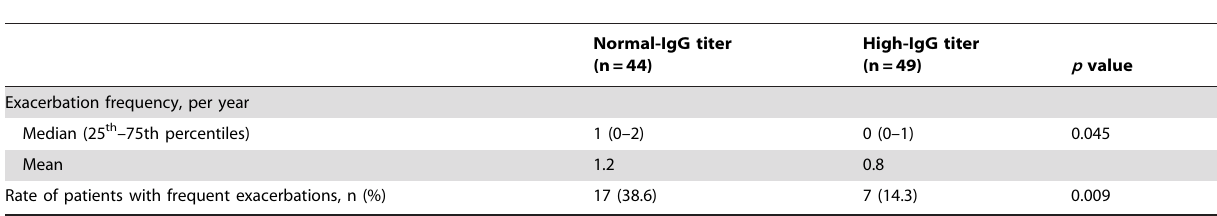
Table 4. Frequency of exacerbations and elevated serum IgG antibody titer against Porphyromonas gingivalis.